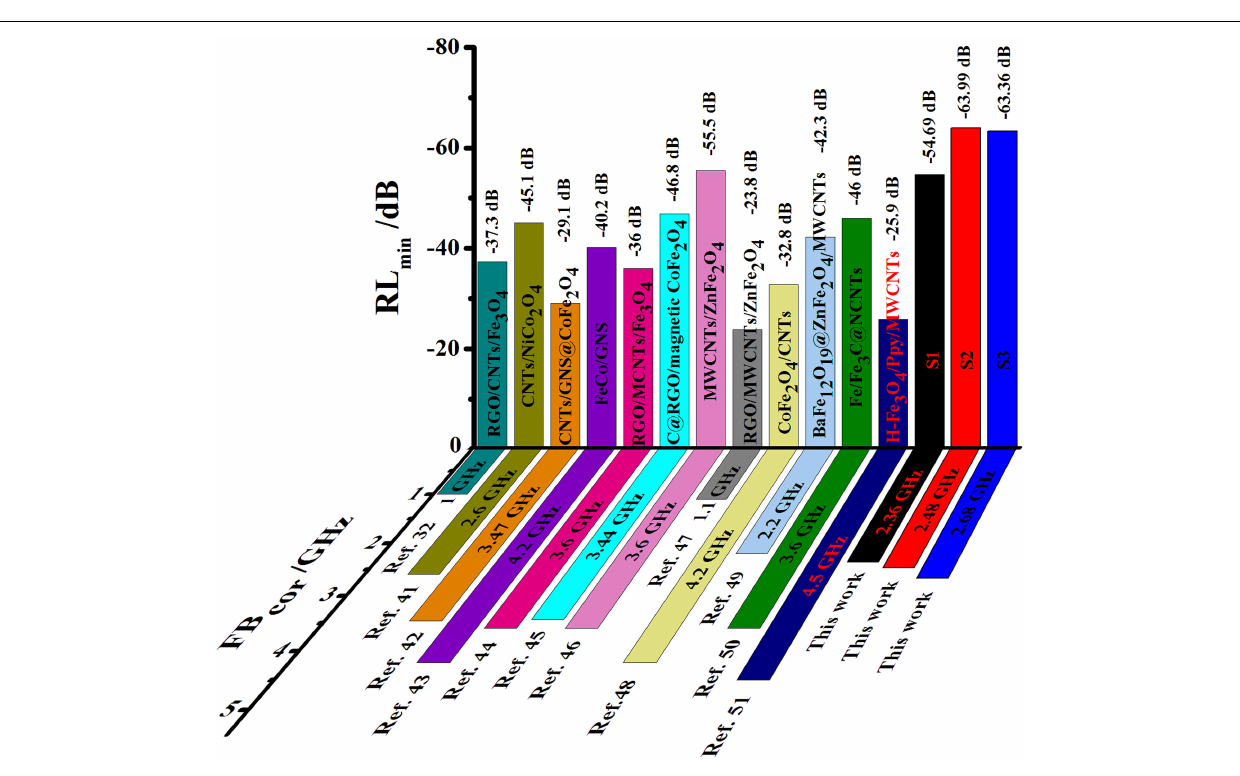
FIGURE 9 | Comparison results of MAPs with the representative NCs reported in recent